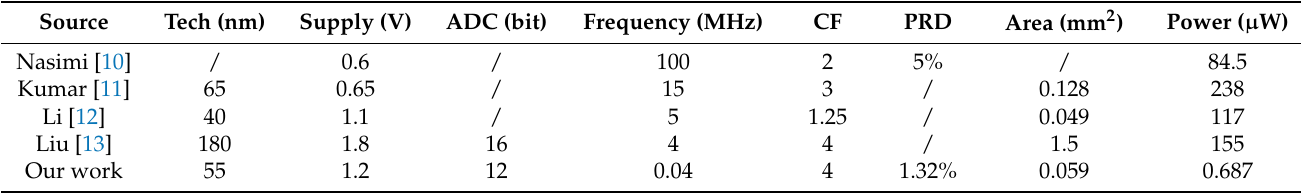
Table 2. CS circuit comparisons with other work.